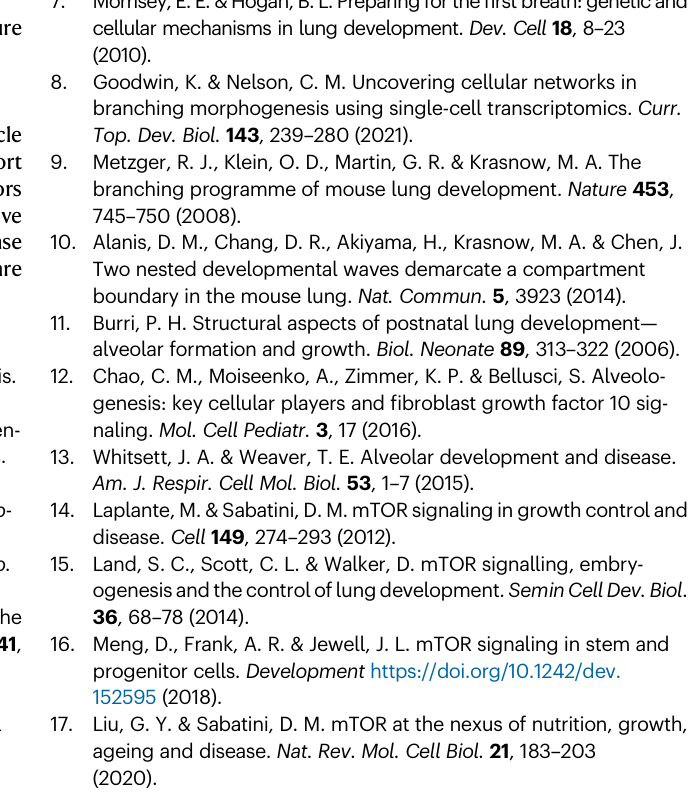
differentiation. b Schematic diagram of lung branching and saccule formation in lungs with disrupted mTORC1 signaling, reduced mitochondrial capacity or per- turbed Hedgehog (Hh) signaling. In these mutants, the conducting airways are missing and are replaced by lung cysts. Saccule-like structures form on the cystic surface. This suggests that distinct programs control lung branching and saccule formation. It also indicates the presence of a developmental clock that controls lung